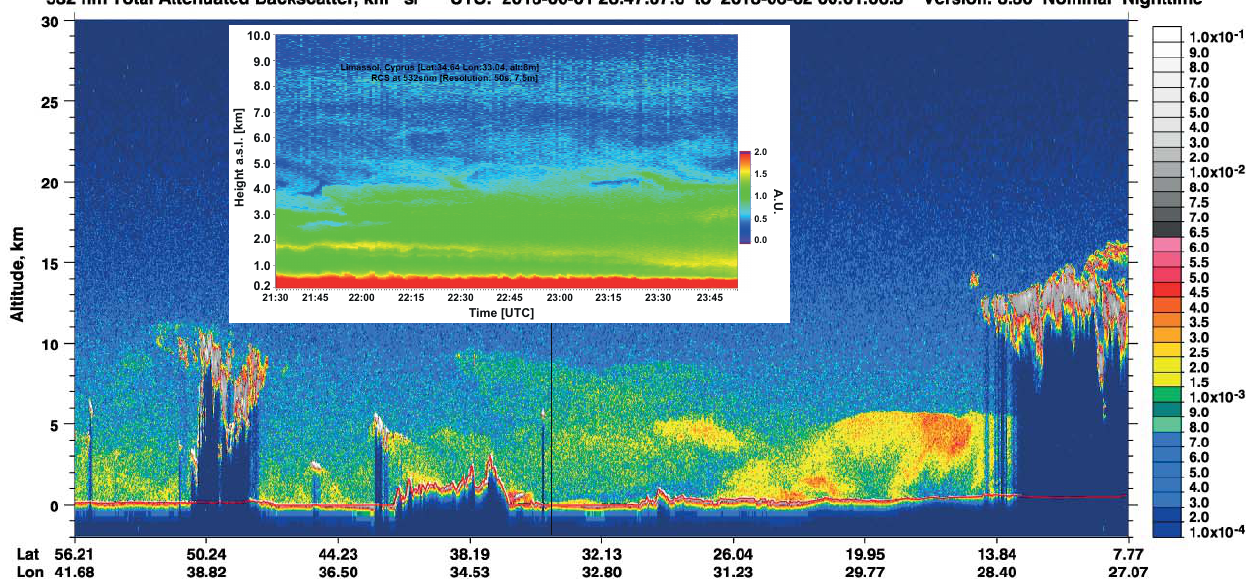
Figure 6. CALIOP measurement (height versus latitude/longitude display) of the attenuated 532nm particle backscatter coefficient during an overpass 45km to the east of Limassol from 1 June 2013, 23:47UTC (universal time coordinated), to 2 June 2013, 00:01UTC. Desert dust layers are given in green to yellow colors and reach up to 4–10km height. The inserted height-time display shows the CUT lidar observation of the range-corrected cross-polarized 532nm backscatter lidar signal on 1 June 2013, 21:30–23:55UTC. Dust (green, yellow, and light blue layers) is observed up to 9–10km height. The vertical black line indicates the closest position of CALIOP (laser footprint) to the ground-based CUT lidar at Limassol, Cyprus.